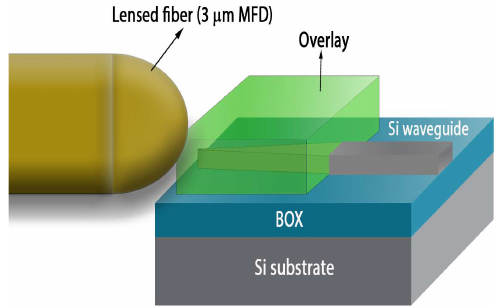
Figure 1. Schematic of edge coupler using inverse-tapers. The fundamental Gaussian mode in lensed fiber with a mode field diameter (MFD) of 3 µ m roughly matches the size of the fundamental waveguide mode at the cleaved end of the overlay